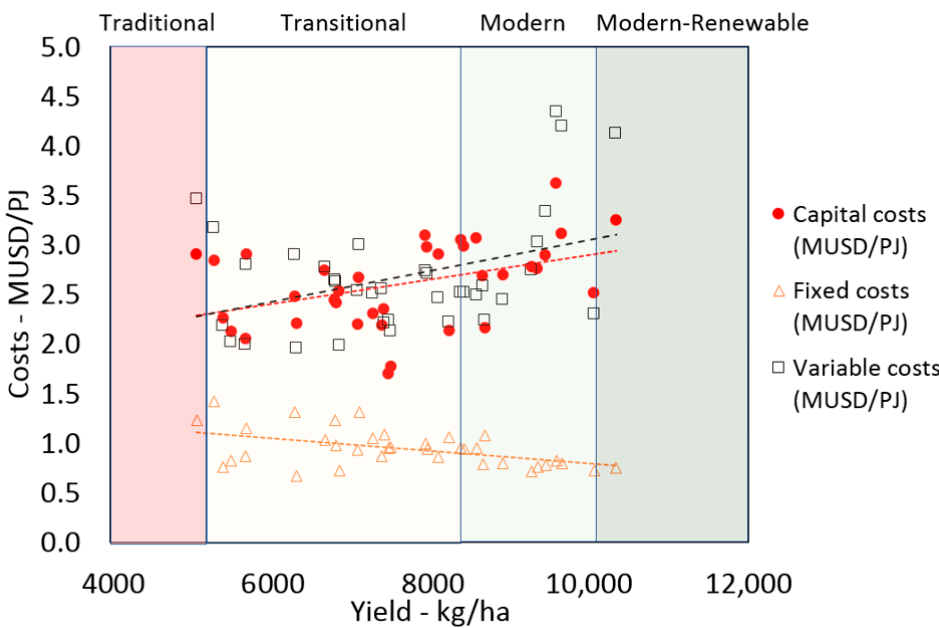
Figure 6. Costs per planted maize energy content, USD2010 PJ y − 1 . Data: USDA [61]. Table 8. Techno-economic data for different mechanisation levels per type of crop.